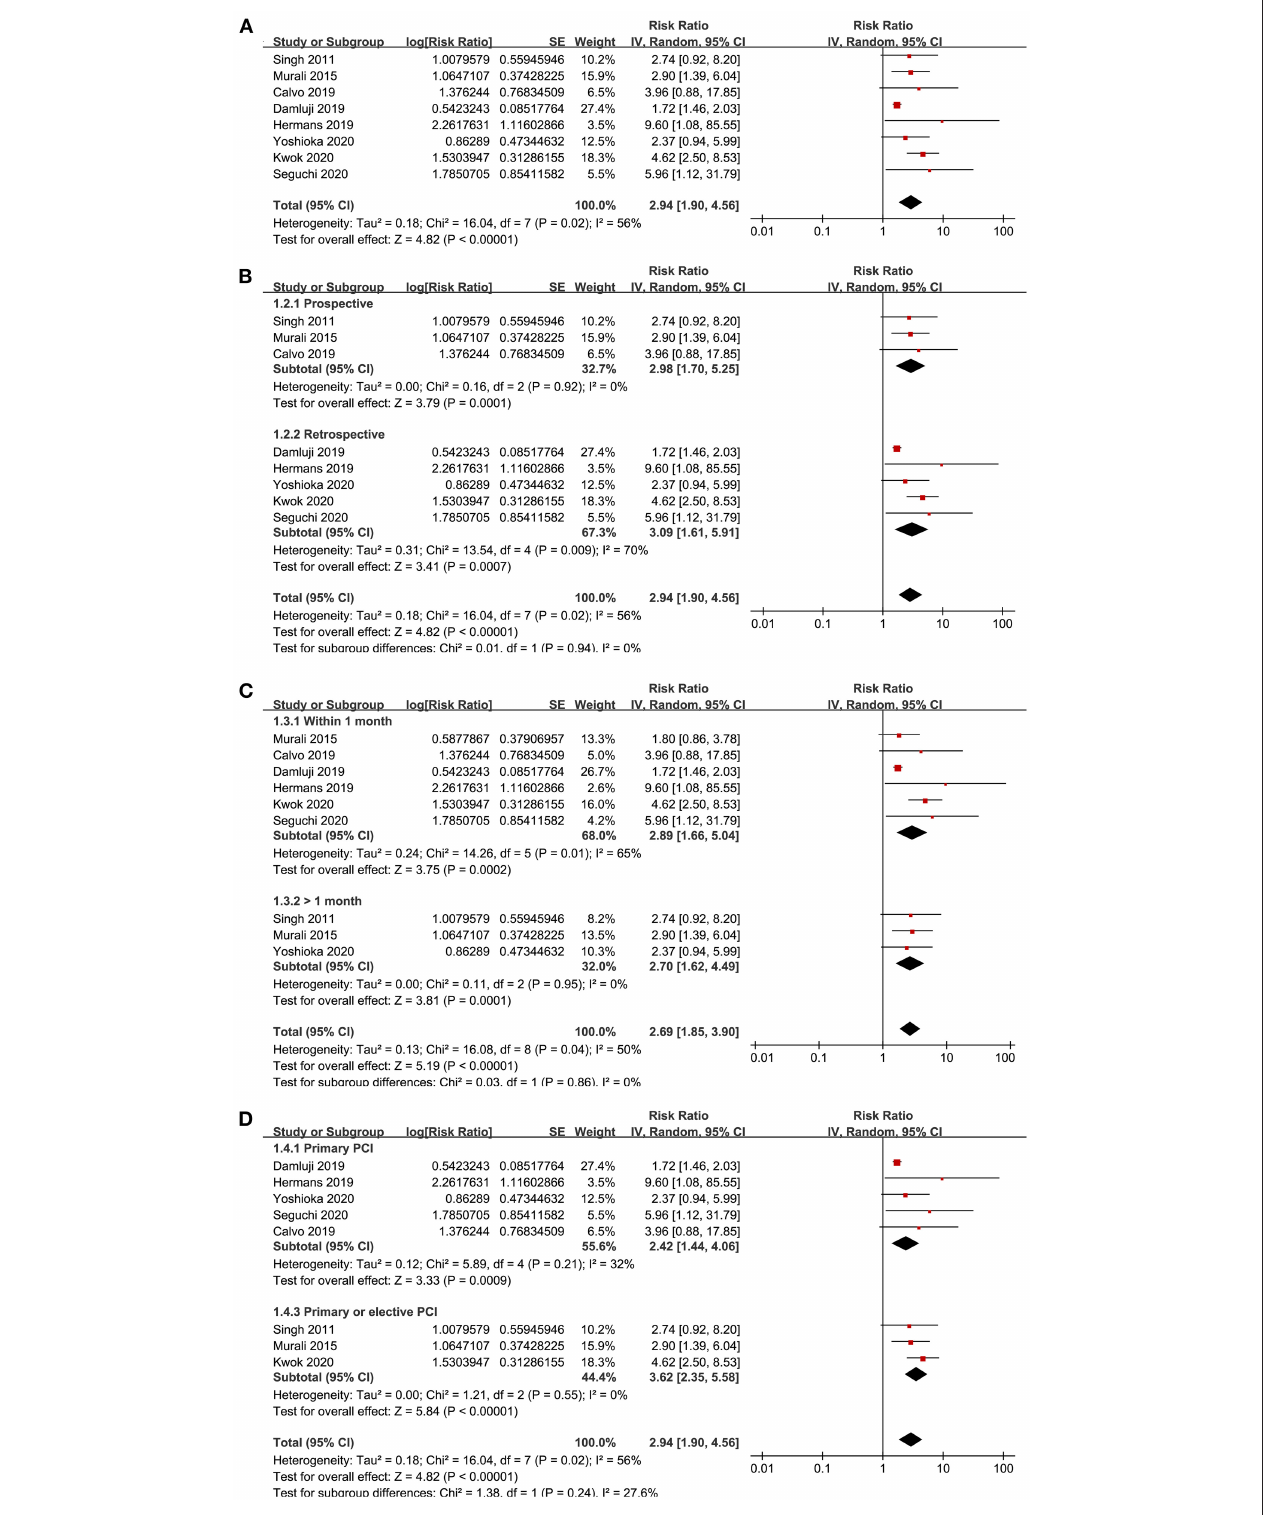
FIGURE 2 | Forest plots for the meta-analysis concerning the association between frailty and risk of all-cause mortality after PCI; (A) , Overall meta-analysis; (B) , Subgroup analysis according to study design; (C) , Subgroup analysis according to follow-up duration; and (D) , Subgroup analysis according to the type of PCI.